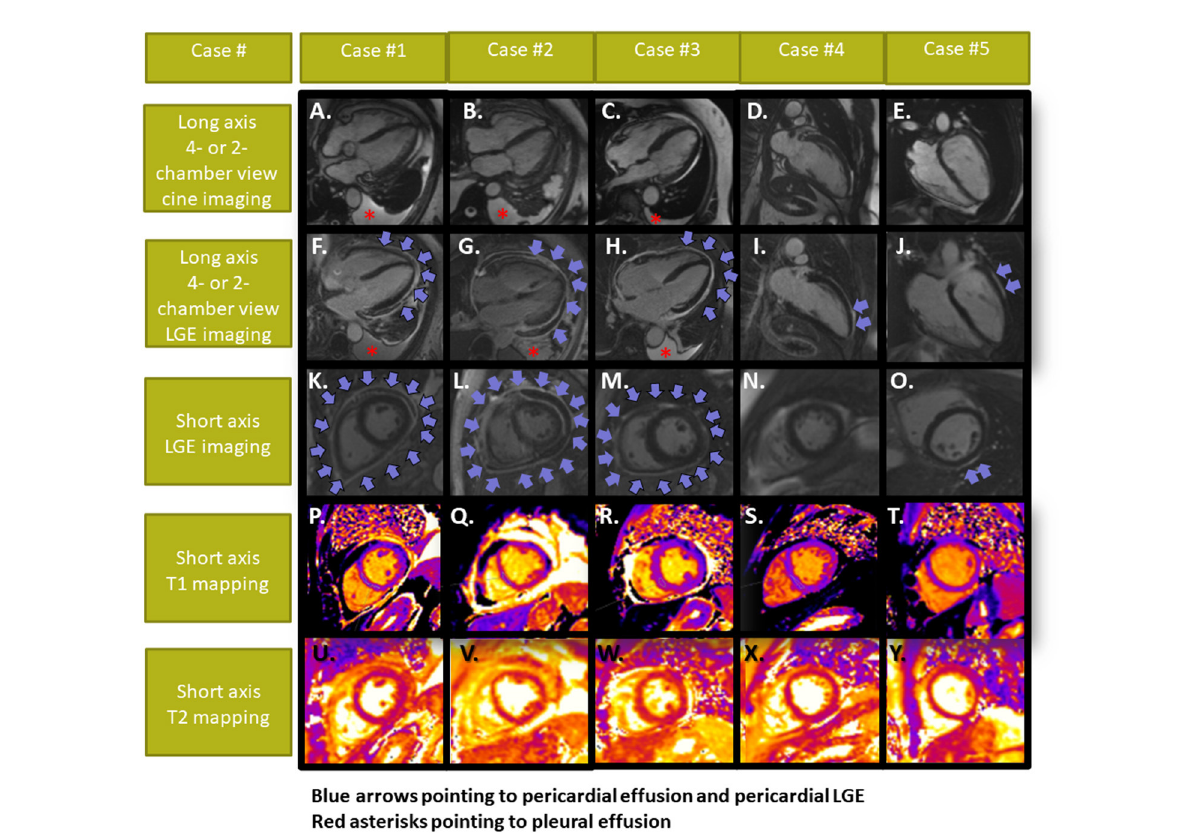
FIGURE2 Cardiac MRI images of patients #1–5. Cine images are displayed in (A–E) . All patients showed pericardial LGE, which was either diffuse [ (F,K) in patient #1; (G,L) in patient #2 and (H,M) in patient #3] or focal [ (I, N) in patient #4 and (J,O) in patient #5], whereas myocardial LGE or elevated T1- and T2-values (P–Y) were not present with any of our patients. Pericardial and pleura effusion was present in patients #1–3. Patient #2 developed signs of a pericardial tamponade and underwent urgent pericardiocentesis (arrows depicting pericardial effusion and LGE in cases #1–3 and pericardial LGE without effusion in cases #4,5; asterisks pointing to the pleura effusions in cases